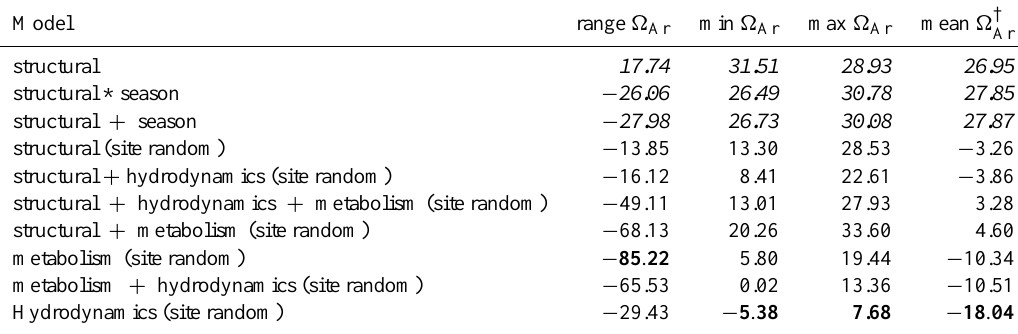
Table 6. Model selection for Generalized Linear Mixed Models (lme4 package in R) predicting (cid:127) Ar with Gaussian distribution and site as random effect (repeated measures). Structural and hydrodynamic components are summarized in the principal component from a PCA analysis (in R), explaining 73 and 99%, respectively of the original parameters. For Metabolism we used the range of oxygen concentration (mgL − 1 ) as a proxy. Aikaike’s information criterion (AIC) is as less-is-better, the best model value is highlighted in bold. Model range (cid:127) Ar min (cid:127) Ar structural